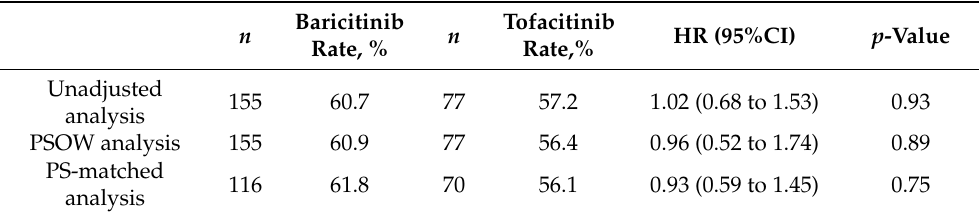
Table 3. Hazard ratios of treatment discontinuation for patients treated with Tofacitinib vs. patients treated with